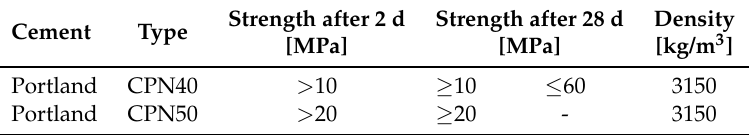
Table 2. Properties of CPN40 and CPN50 cements employed in the experimental